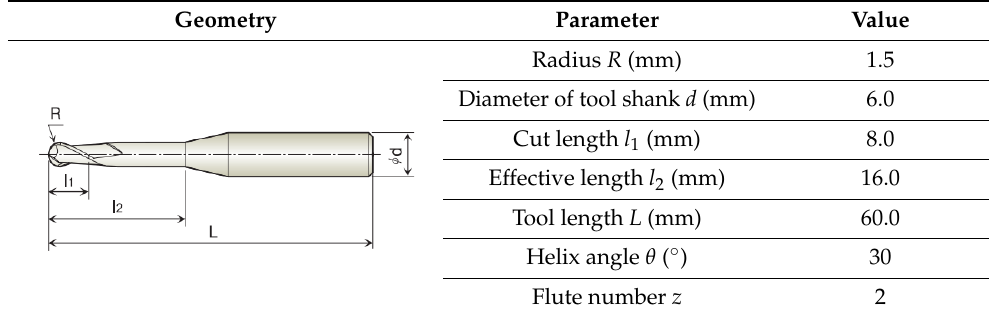
Table 2. Tool specifications.